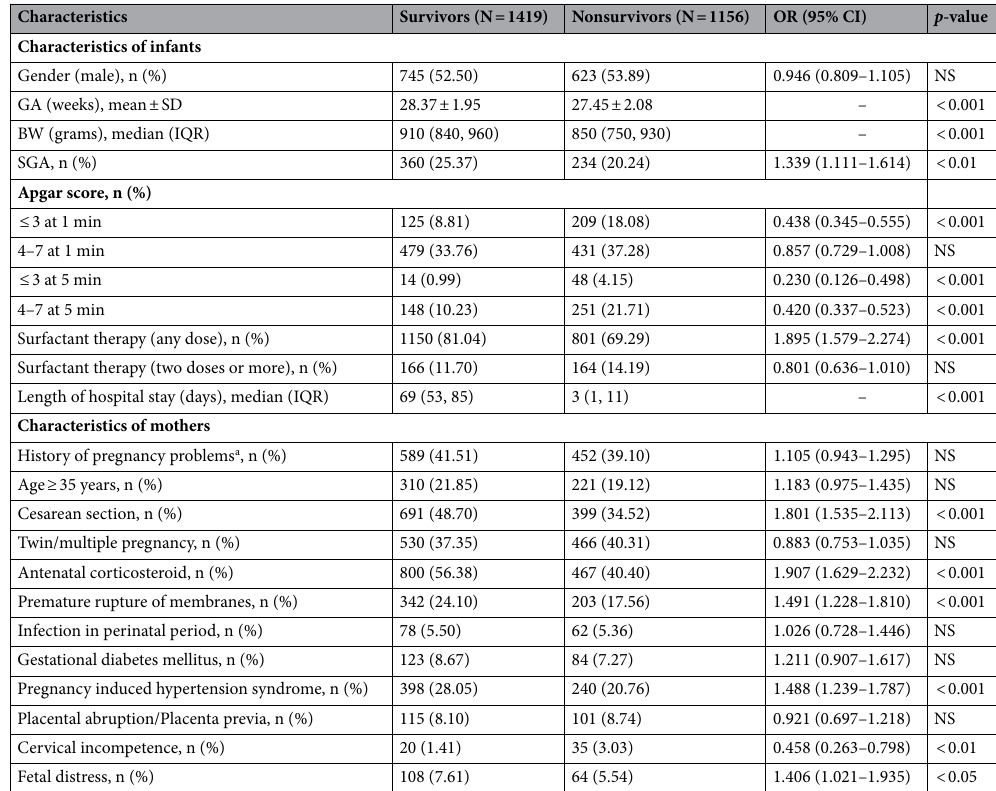
Table 1. Demographics of extremely low birth weight (ELBW) infants and the mothers in outcome categories. GA, gestational age; BW, birth weight; SD, standard deviation; IQR, interquartile range; SGA, small for gestational age; OR, odds ratio; CI, confidence intervals; NS, no significant difference. a History of pregnancy problems refers to that the mother had at least one of the histories as follow: spontaneous abortion, induced abortion, stillbirth, preterm birth, ectopic pregnancy, or baby died during neonatal